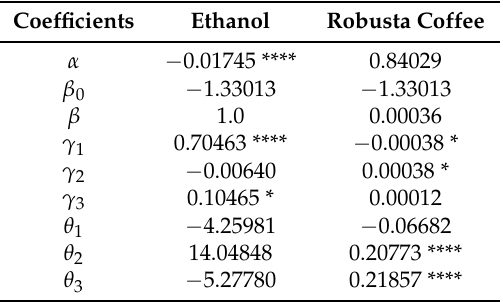
Table 4. The VECM for the ETH-Robusta coffee (ROB) pair in P 1 . Significance levels: 10% (*), 5% (**), 1% (***) and 0.1%